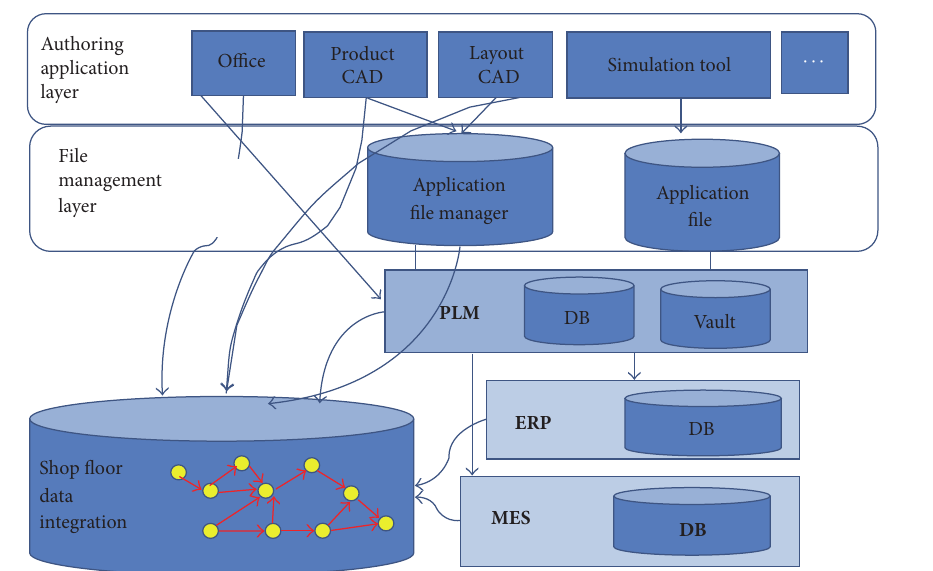
Figure 6: IT system architecture reference to support digital